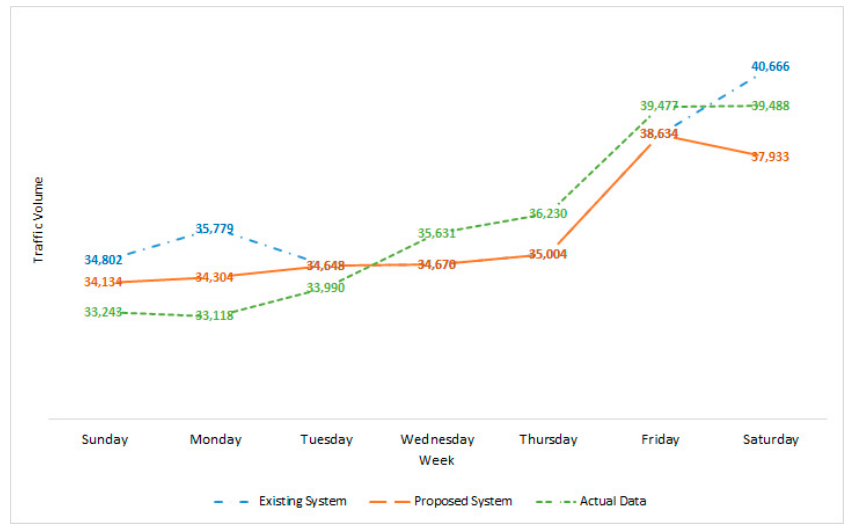
Figure 16. Comparison graph of the traffic volume for actual